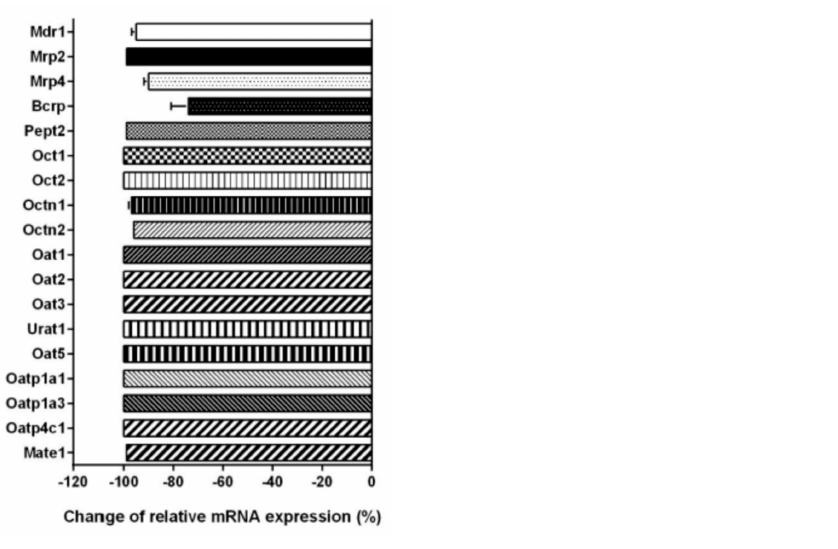
Figure 10. Change in relative mRNA expression of transport proteins in PRPTCs after 5 days in culture. The mRNA expression of each gene was normalized to Gapdh expression and is shown in reference to the expression level of each gene in freshly isolated PRPTCs, which was set to 1. Each bar represents the mean ± SD ( n = 3).